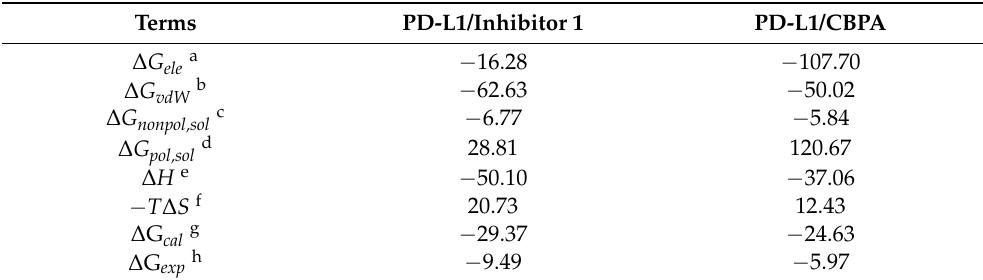
Table 1. ∆ G bind for the two inhibitors (inhibitor 1 and CBPA) bound to PD-L1 with the MM/GBSA method